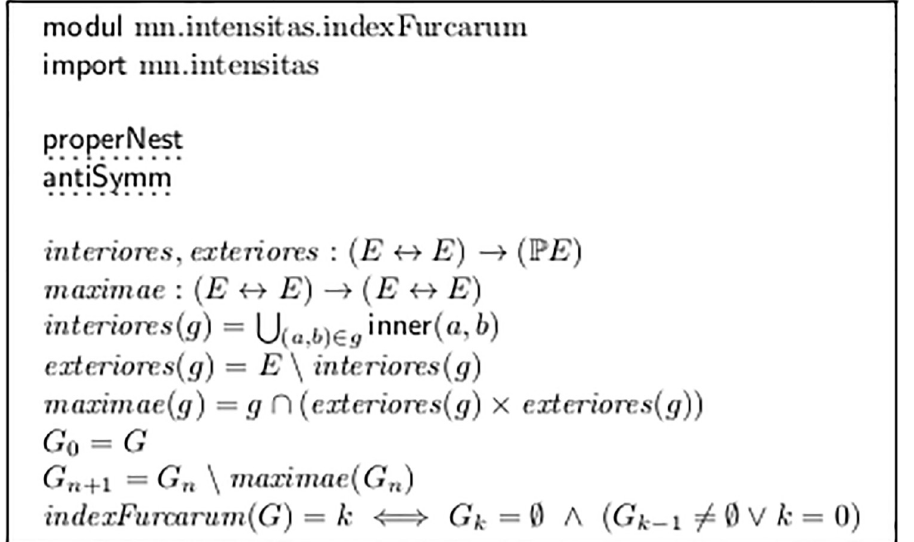
Fig 5. Counting fork nesting